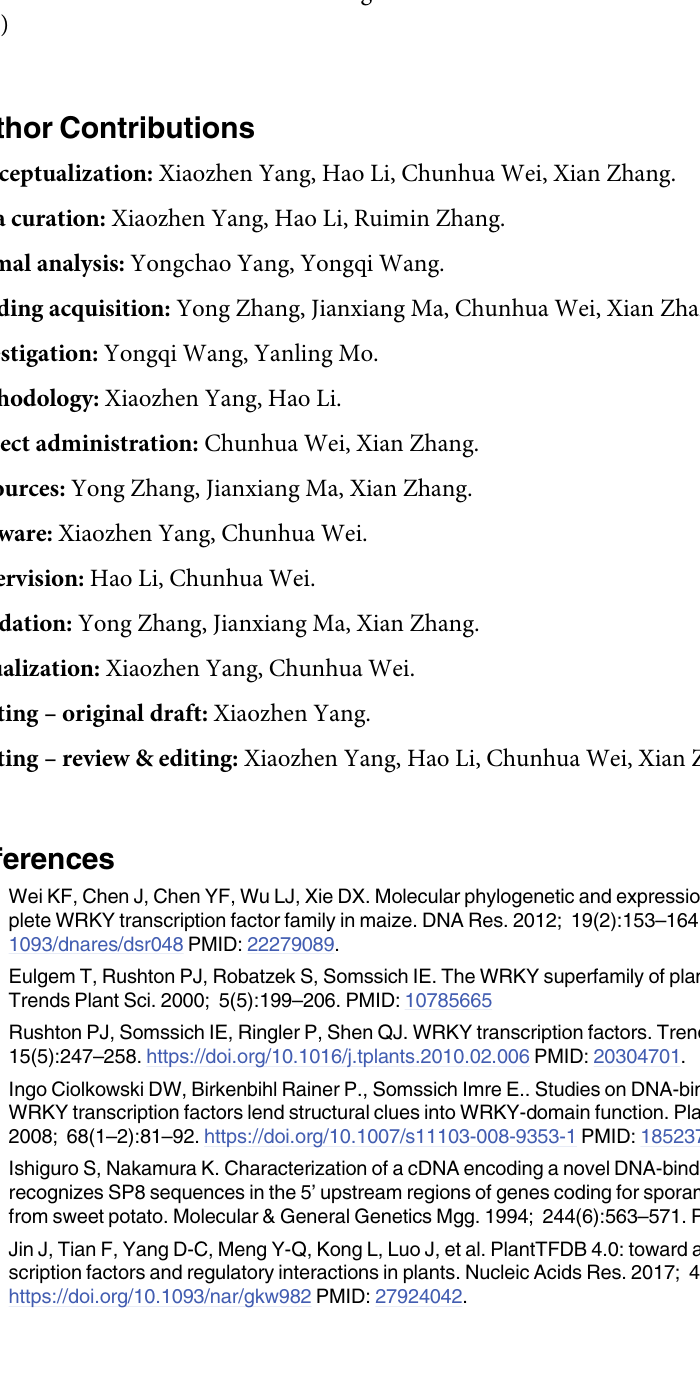
S6 Table. Number of WRKY TF gene family members present in major crop plants and horticultural plants. S7 Table. The relative expression of watermelon WRKY genes via qRT-PCR in response to various abiotic stresses and hormone treatments. S1 Fig. Genetic map position on watermelon chromosomes of WRKY gene family. The numbers indicate the start site of WRKY genes located on